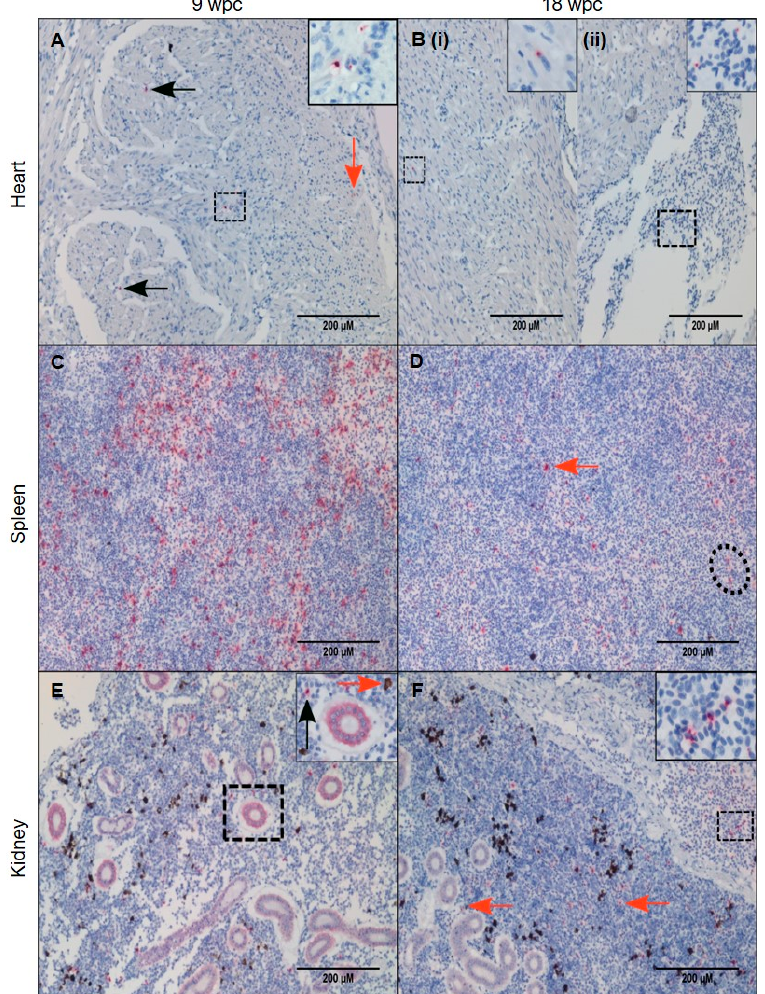
Figure 5. PRV-1 localization during the persistent phase. PRV-1 localization shown by in situ hybridization (red) at 9 and 18 wpc. Heart ( A , B ): A, (9 wpc) A small number of cells in the compact layer stained positive for PRV-1 (orange arrow), and similarly faintly in a few macrophage-like cells in the luminal space of the spongy layer (black arrows) and some circulatory cells, near blood vessel (dotted square and magnified image). B, (18 wpc) Very few cells were positive for PRV-1 with the exception of (i) some positive cardiomyocytes in the spongy layer (dotted square) or (ii) peripheral blood in the heart (dotted square). Spleen ( C , D ): C, (9 wpc) numerous PRV-1 positive cells in red pulp. D, (18 wpc) A few PRV-1 positive macrophage-like cells (orange arrow) and erythrocyte like cells (dotted circle). Kidney ( E , F ): E, (9 wpc) PRV-1 present in macrophage-like cells (black arrow) and melano-macrophages (orange arrow). F, (18 wpc) PRV-1 positive erythrocytes and macrophage-like cells throughout the section (orange arrows) and in blood vessels (magnified picture). Scale bar = 200 µ